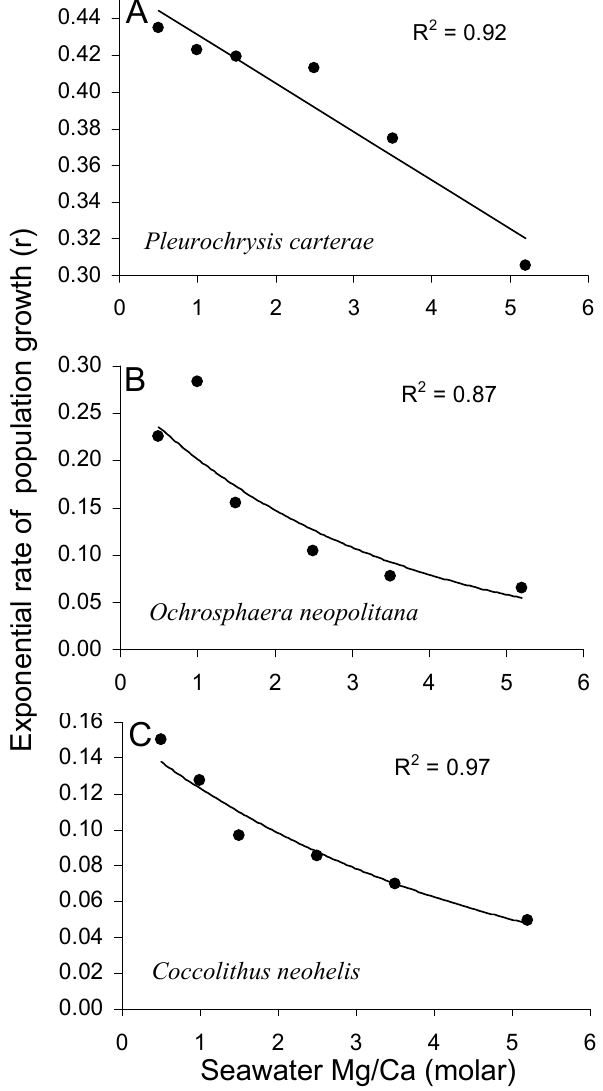
Fig. 12. Exponential rates of population growth ( r) as a function of seawater Mg/Ca ratio for the coccolithophore species Pleurochry- sis carterae (A) , Ochrosphaera neopolitana (B) , and Coccolithus neohelis (C) . Rates of population growth increased significantly ( p < 0 . 05) for each of the three species as seawater Mg/Ca de- clined into the calcite stability field, which favors precipitation of the coccolithophores’ calcite skeletal mineral. Fitted curve in (A) is linear, while fitted curves in (B) and (C) are exponential. Spear- man rank correlation ( r s ) =0.99 for all three species. From Stanley et al.